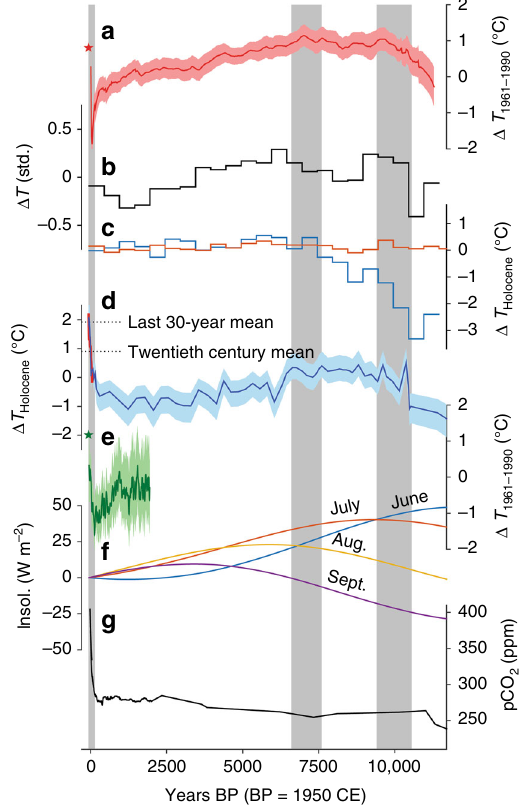
Fig. 5 Δ T reconstructions and climate forcings. a Northern